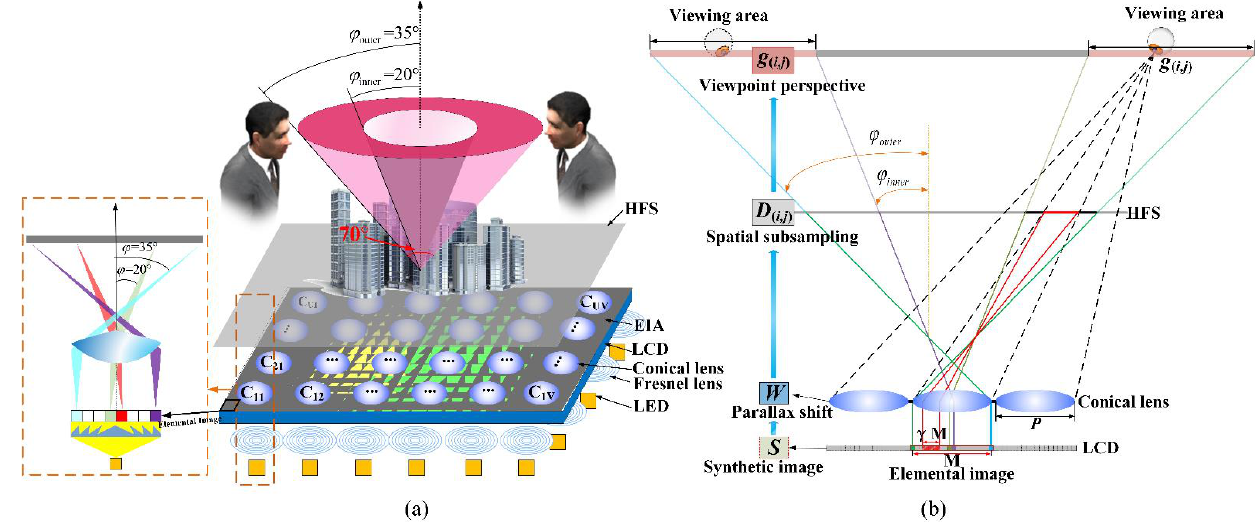
Figure 3. ( a ) The configuration of 360-degree 3D light-field display system. ( b ) Modeling the 3D light-field display.